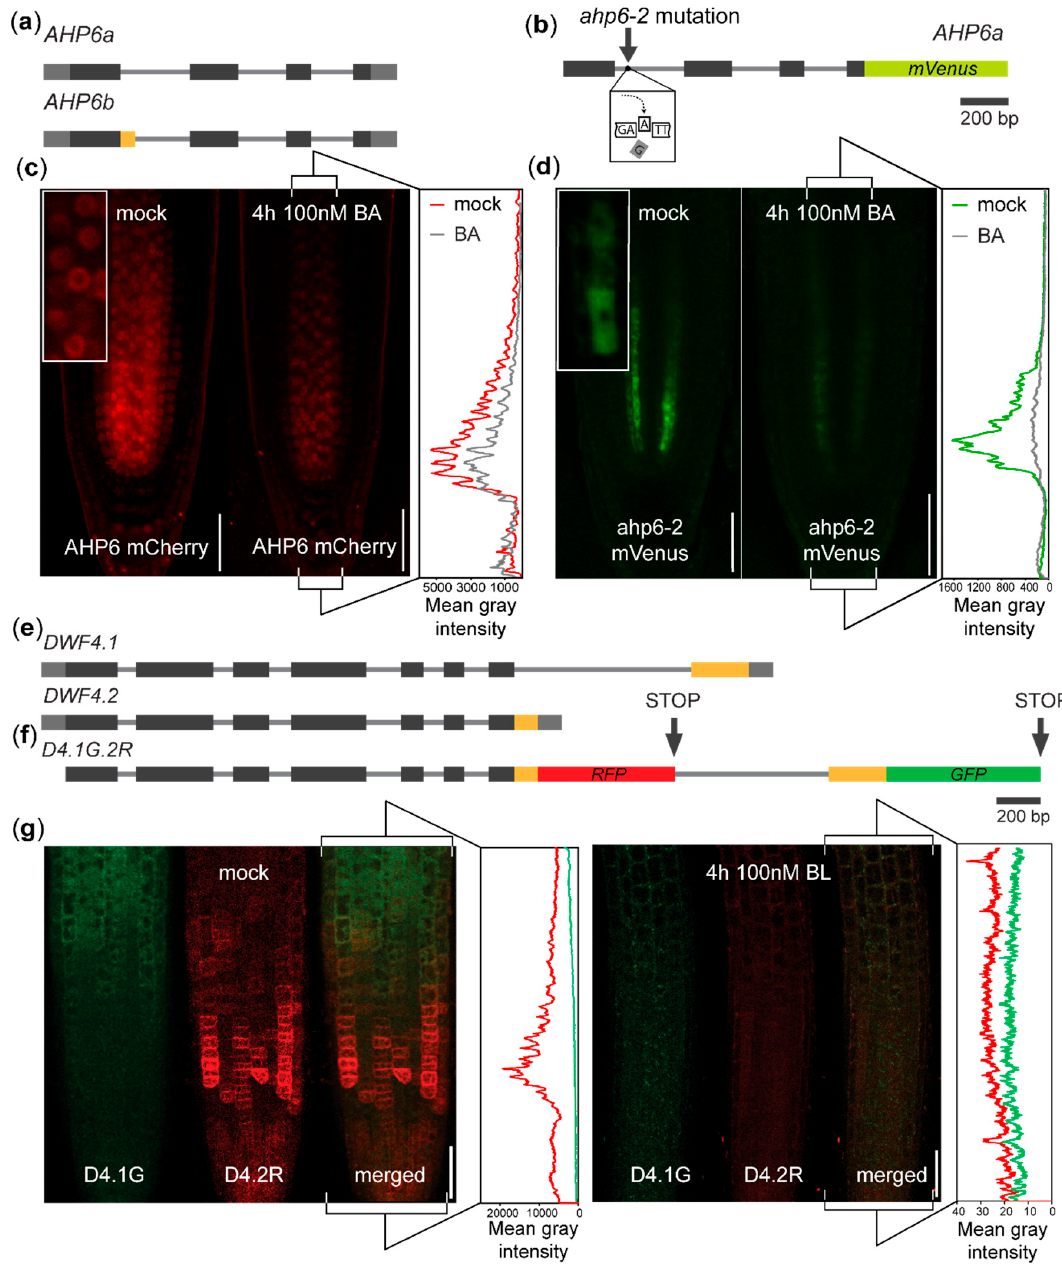
Figure 1. Reporters visualizing AS of AHP6 and DWF4 in the root tip: ( a ) Diagram of the coding regions of the AHP6 gene. ( b ) Scheme of the ahp6-2-mVenus reporter for visualizing the AHP6a-mVenus isoform. ( c ) AHP6:AHP6-mCherry line, containing the genomic AHP6 sequence, shows that the AHP6 protein is distributed throughout the root tip stele [21] (left); the treatment with the synthetic cytokinin benzyladenine (BA) decreases the expression of the wild type AHP6:AHP6-mCherry . Note the predominantly nuclear presence of the AHP6-mCherry foci (inset). ( d ) AHP6:ahp6-2-mVenus is present only in the protoxylem founder cells and neighboring pericycle (left); following the treatment with BA, the reporter expression decreases even more notably. Inset: a perinuclear cytoplasmic or endocompartment localization of ahp6-2-mVenus. ( e ) Diagram of the coding regions of the DWF4 gene. ( f ) Scheme of the D4.1G.2R reporter visualizing the DWF4.1 and DWF4.2 expression. ( g ) Following the treatment with brassinolide (BL), the fluorescence signal drops below the detection limit of the microscope. Bars, 100 µ m, on ( c ), ( d ) and ( g ). Black—coding regions, grey—UTRs, thin grey line— introns, yellow—regions changed by AS, red—RFP, green—GFP, on ( a ), ( b ), ( e ) and ( f